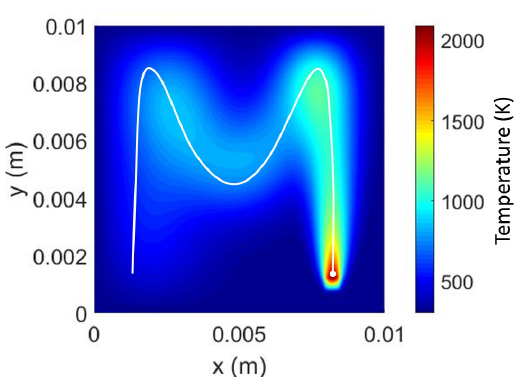
Figure 7. Temperature solution for the laser trajectory presented in Figure 2a obtained by the brute-force method [24]. No FFT or Discrete Sine Transform (DST) is used.